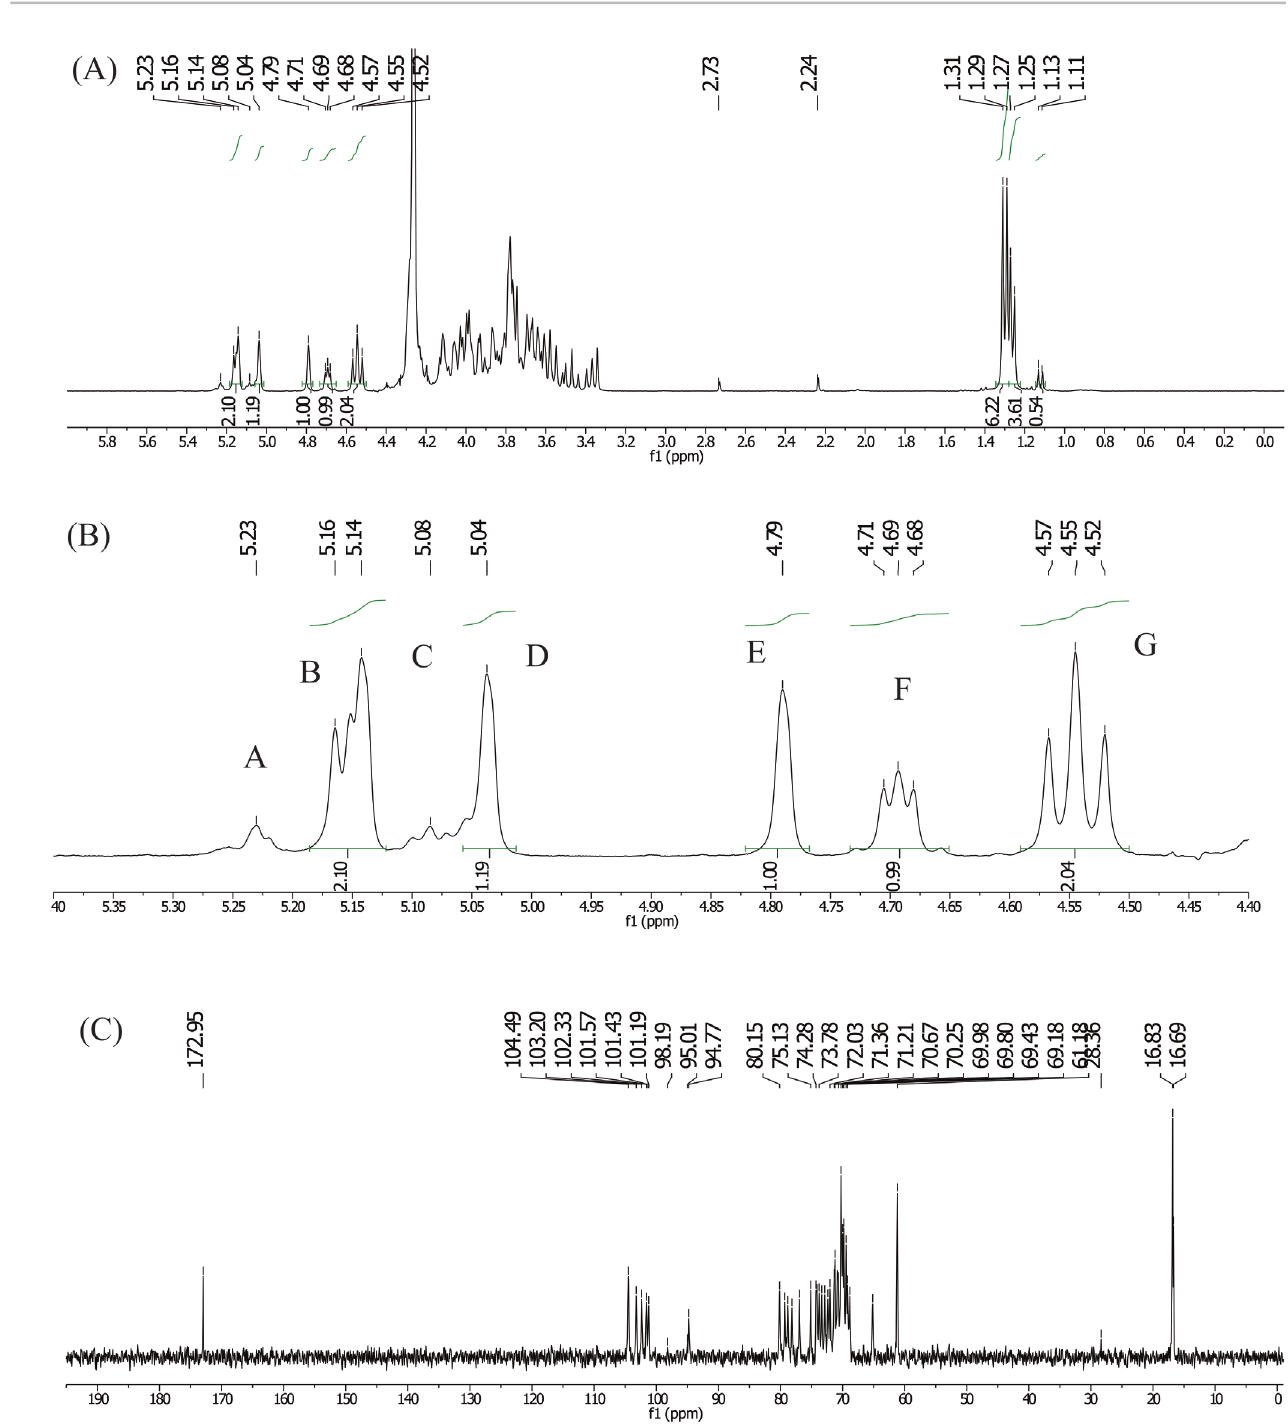
FIGURE 1 - NMR spectra of the KEPS from K. oxytoca in D region of the 1 H NMR spectrum; (C) 13 C NMR spectrum (75.45